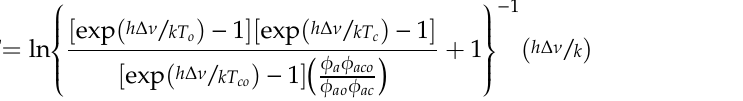
Figure 7. Temperature measurement results of FUT.